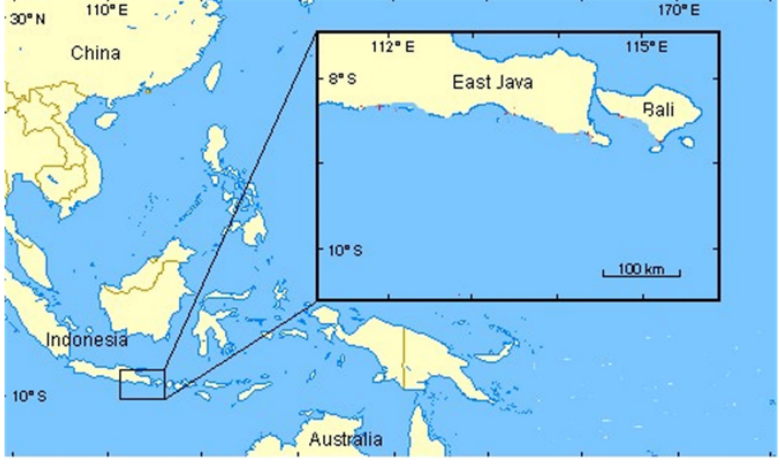
Figure 1. Location of the East Java 150 kV power system.